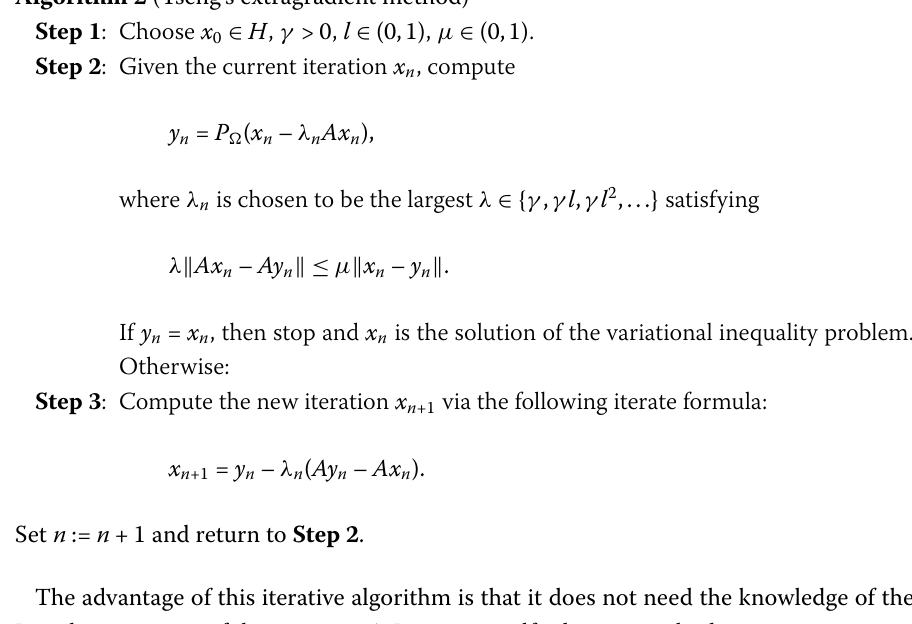
Algorithm 2 (Tseng’s extragradient